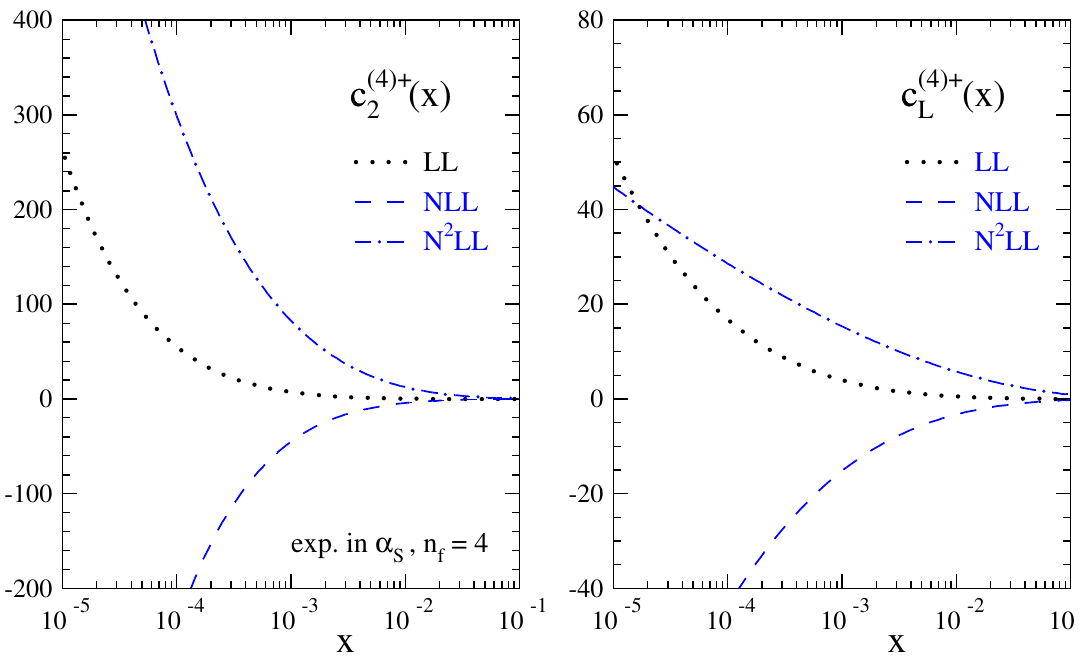
Figure 2 . The LL, NLL and NNLL small- x approximations to the fourth-order non-singlet coefficient functions c (4)+ ( x ) and c (4)+ ( x ) for n = 4 light flavours. Eqs. (4.5) and (4.6) have been transformed 2 f L to x -space using eq. (2.24) and converted to an expansion in powers of α s by a multiplication with 1 / (4 π ) 4 .